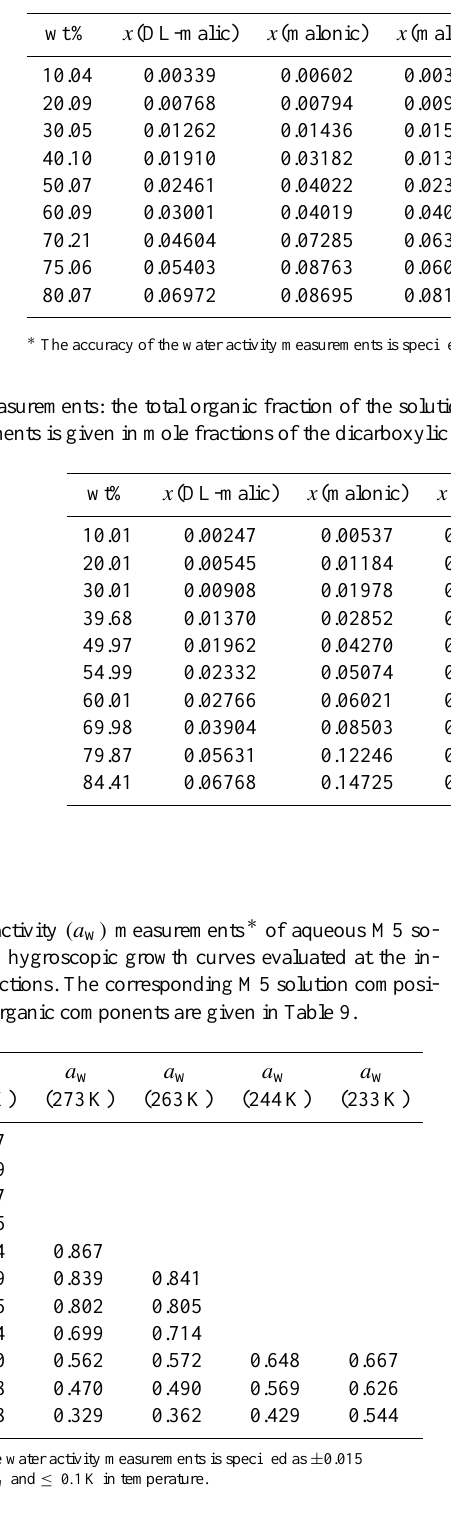
Table 8. Bulk water activity (a w ) measurements ∗ of aqueous M5 solutions at 279.15K. The total organic fraction of the solution is given in the first column in wt% and the composition in terms of individual components is given in mole fractions of the dicarboxylic acids constituting the M5 mixture.